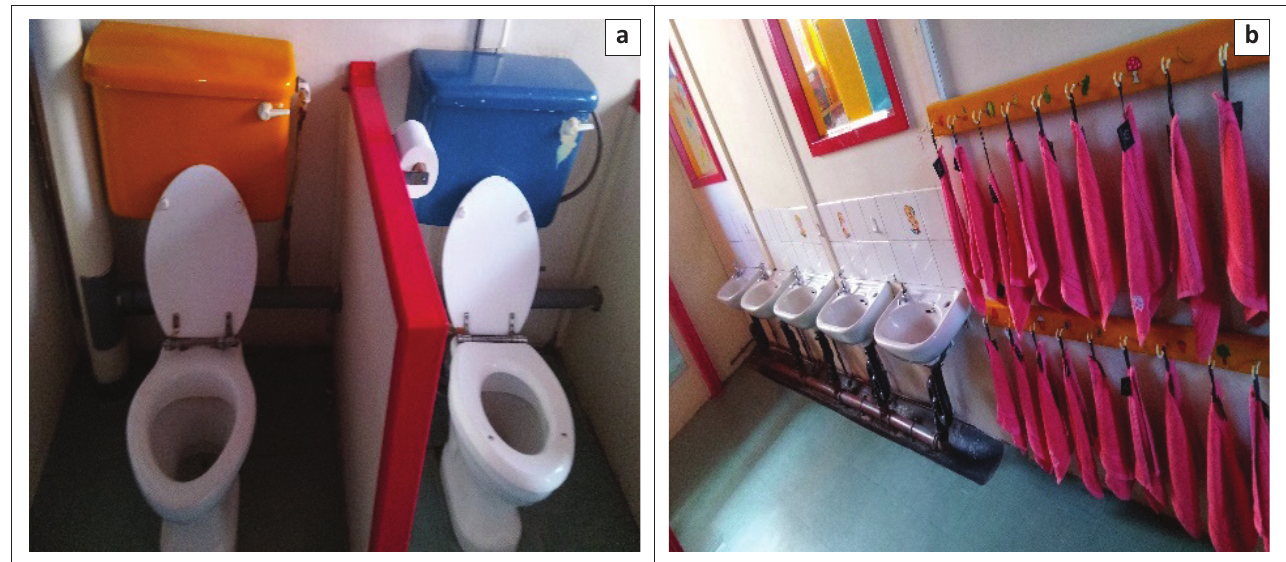
FIGURE 3: Photos (a-b) of suburban centre C’s toilet